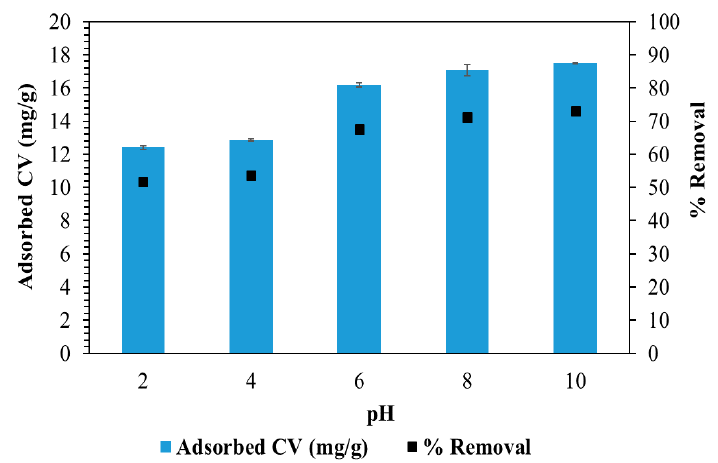
Figure 3. Effect of solution pH (2–10) on CV adsorption to BC-PKS (initial concentration: 400 mg/L; volume: 30 mL; adsorbent dosage: 0.5 g; reaction time: 24 h; temperature: 25 ° C).